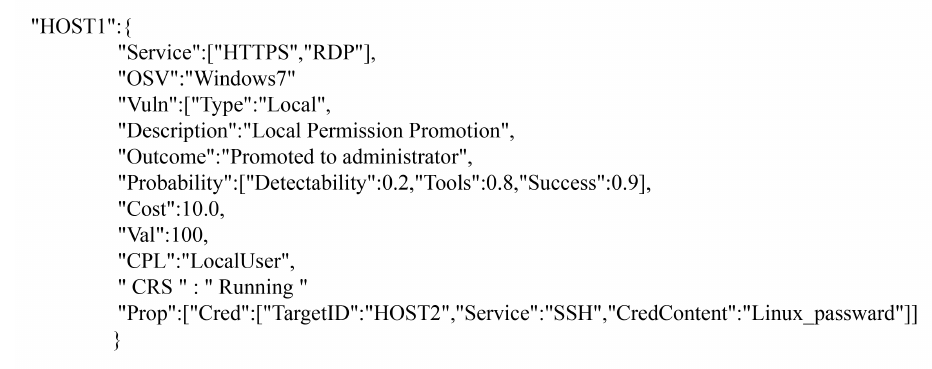
Figure 3. Setting of host attributes according to the definition.